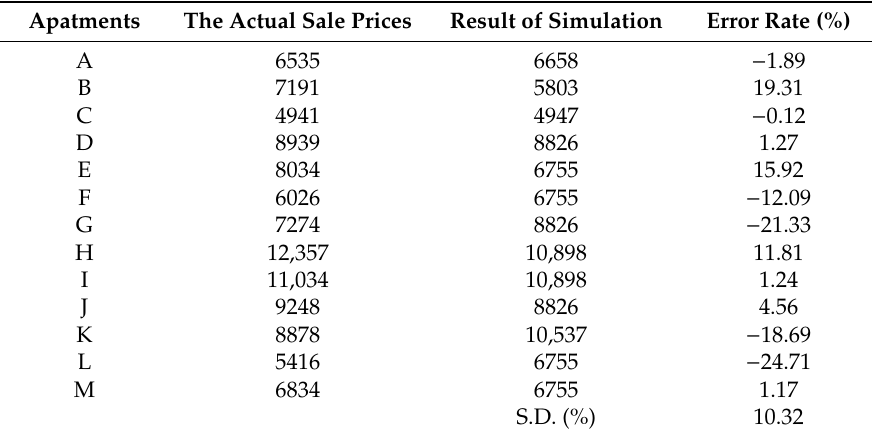
Table 4. The error rate and deviation rate of the